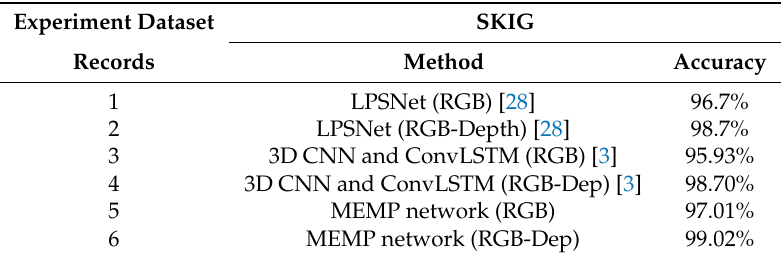
Table 6. SKIG experimental results.